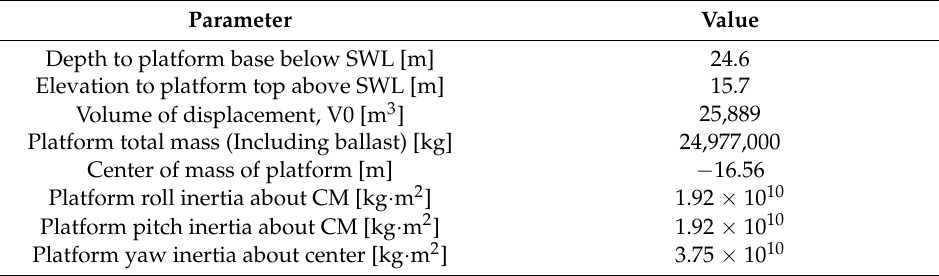
Table 2. Specifications of the 10 MW S-FOWT Platform.